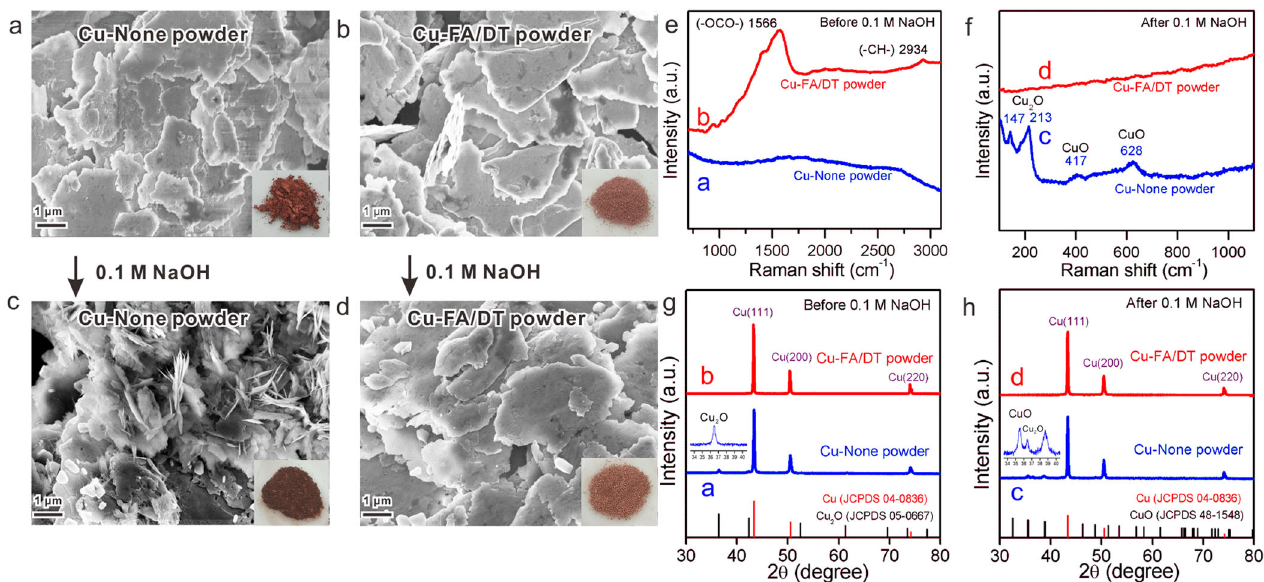
Fig. 2 Effects of FA/DT surface passivation on commercial copper micro fl akes. Copper powder before and after alkali resistance test in 0.1 M NaOH at room temperature for 24 h. SEM images of a , c Cu-None powder and b , d Cu-FA/DT. Raman spectra of Cu-None powder, Cu-FA/ DT powder before ( e ) and after ( f ) the alkali resistance test. XRD patterns of Cu-None powder, Cu-FA/DT powder before ( g ) and after ( h ) the alkali resistance